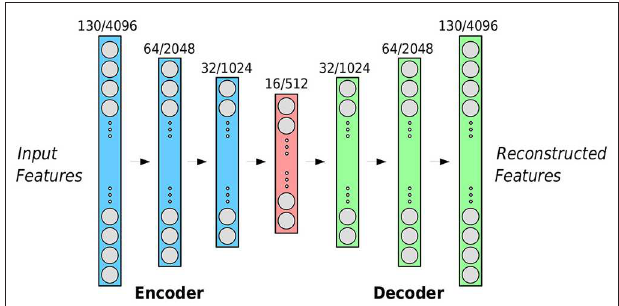
FIGURE 2 | The autoencoder framework implemented for our study. The error between the input features (left) and the reconstructed features (right) is minimized for each subject using the RMSE. The given number of neurons in each layer (indicated above the neurons) refers to the COMPARE / DEEP SPECTRUM features, respectively.